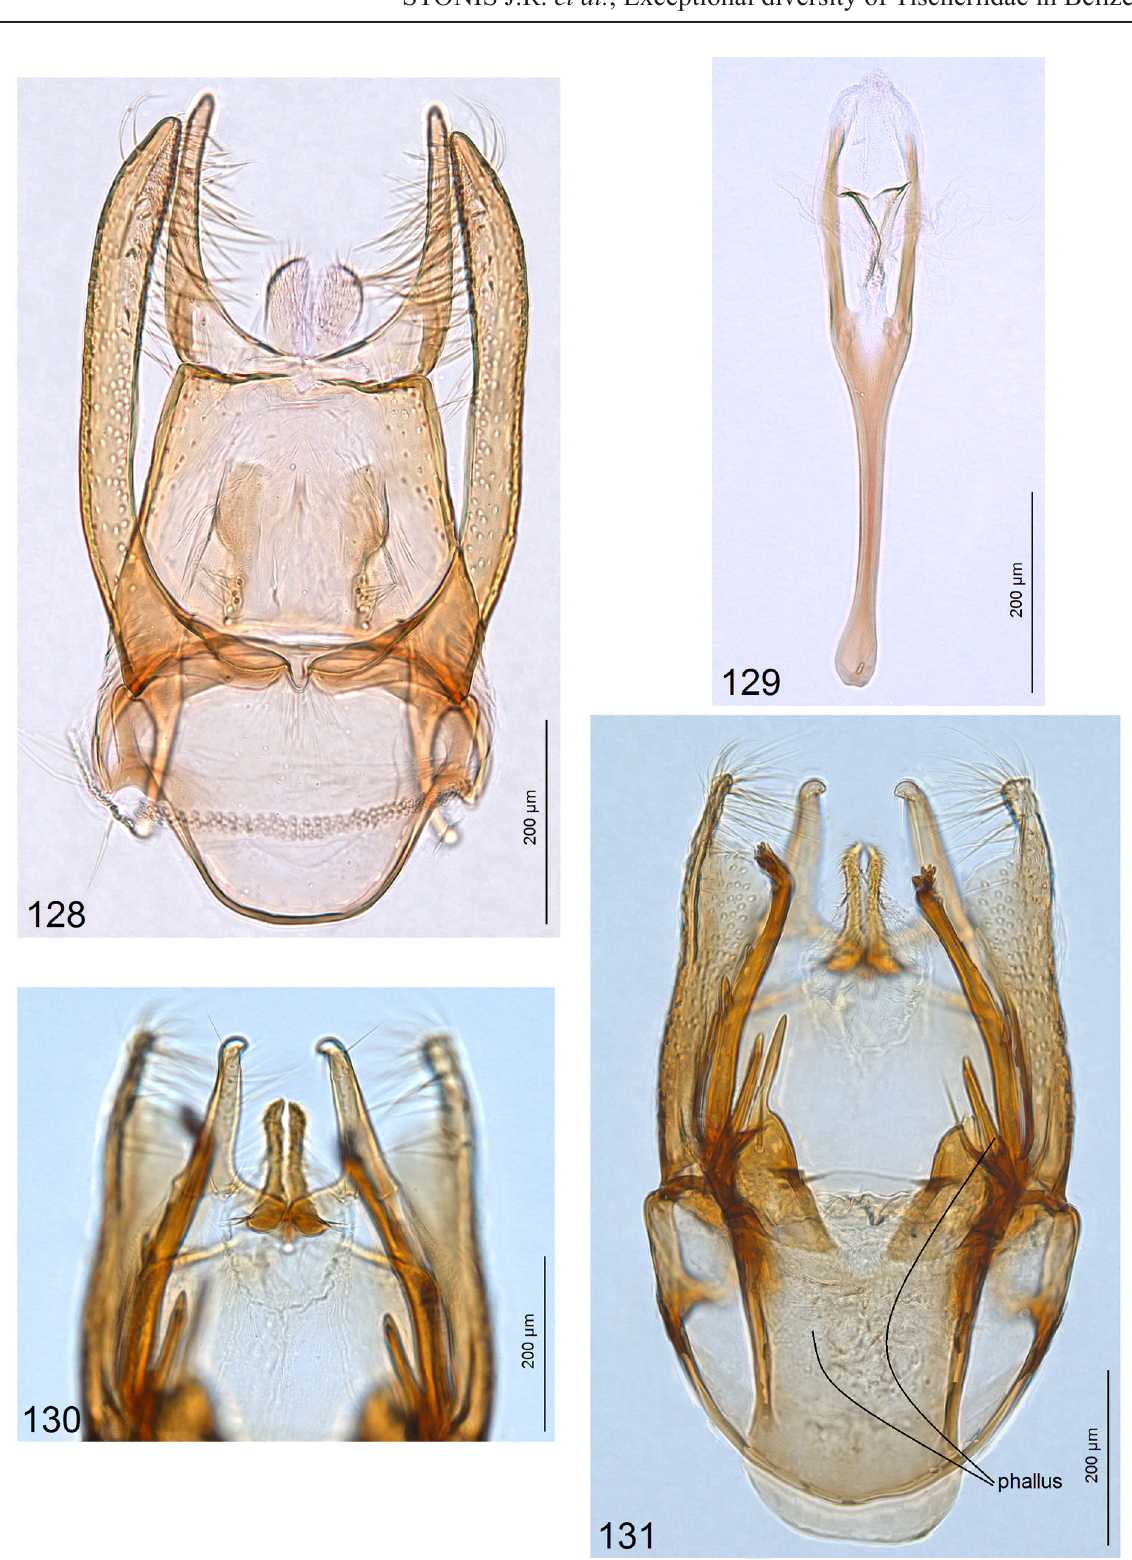
Figs 128–131. Male genitalia of Tischeriidae from Las Cuevas, Belize (NHMUK). 128 . Paratischeria neotropicana (Diškus & Stonis, 2015), capsule with phallus removed (genitalia slide no. 010316205). 129 . Same, phallus. 130–131 . Dishkeya gouaniae (Diškus & Stonis, 2007), paratype (genitalia slide no.